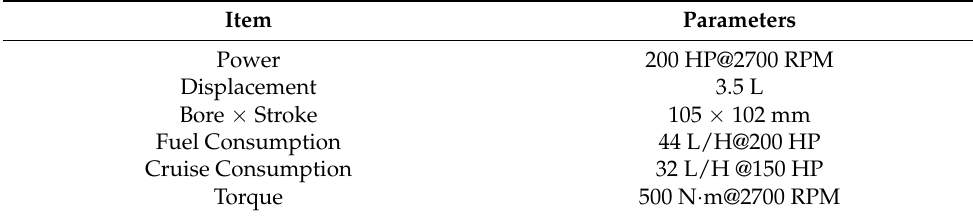
Table 1. Engine specifications.